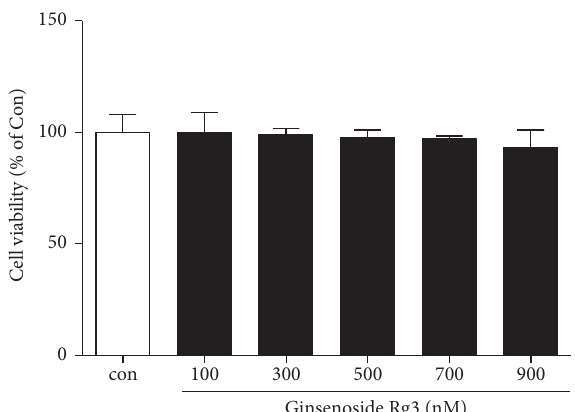
Figure 1: Cell viability assay of Rg3 on IL-1 𝛽 -induced inflamed A549 cells. After treatment of IL-1 𝛽 (10ng/ml) and Rg3 (100–900nM) on the A549 cells, MTT assay was performed. The cytotoxicity of Rg3 on IL-1 𝛽 -induced inflamed A549 cells was not detected. Statistical significance was determined by unpaired 𝑡 test (one-tailed) compared to Con (only treated PBS).